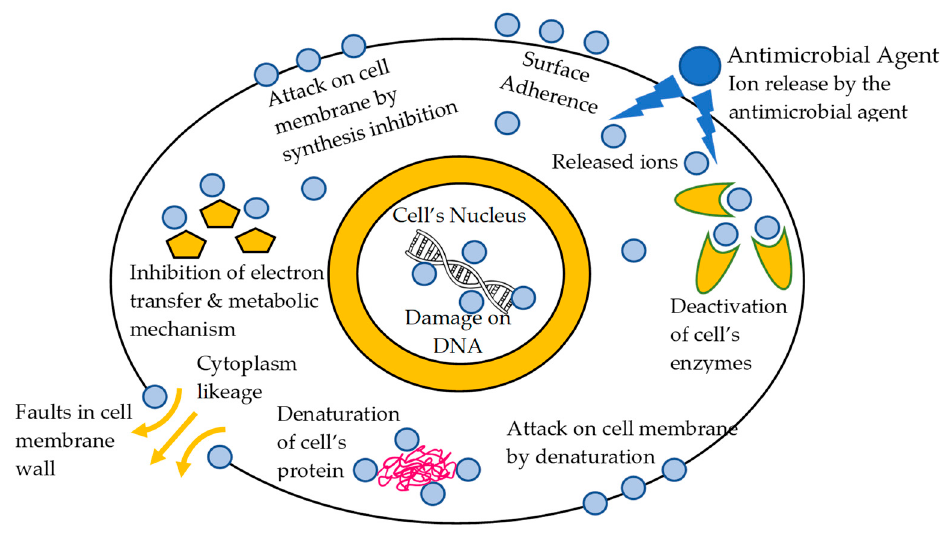
Scheme 1. General chemical structure of quaternary ammonium compounds